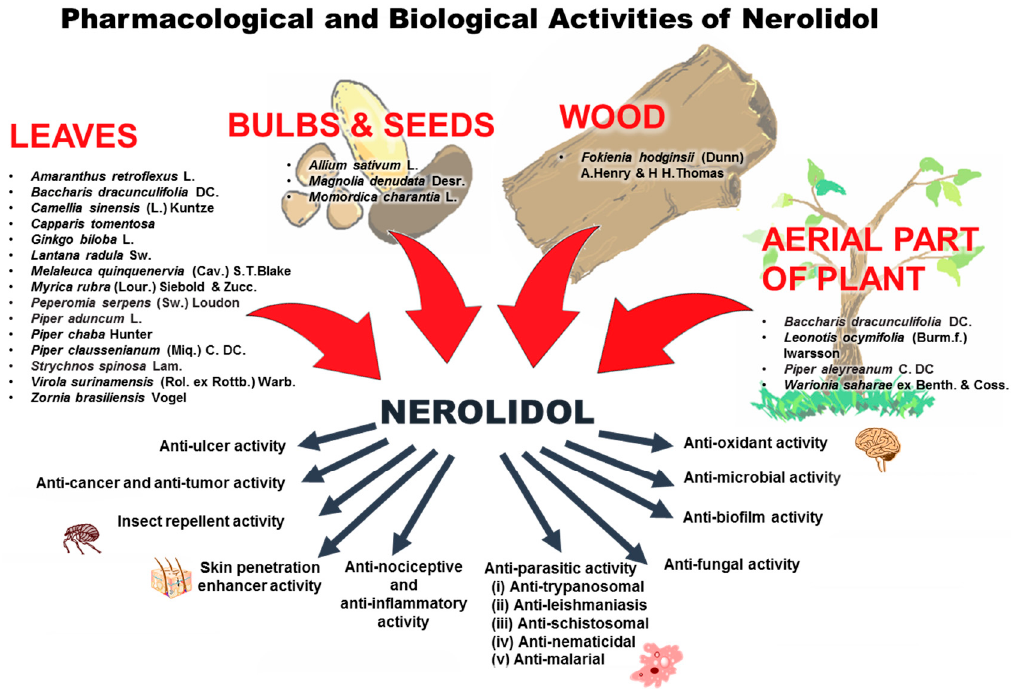
Figure 2. The source of extraction of nerolidol and an overview of the biological activities of nerolidol.